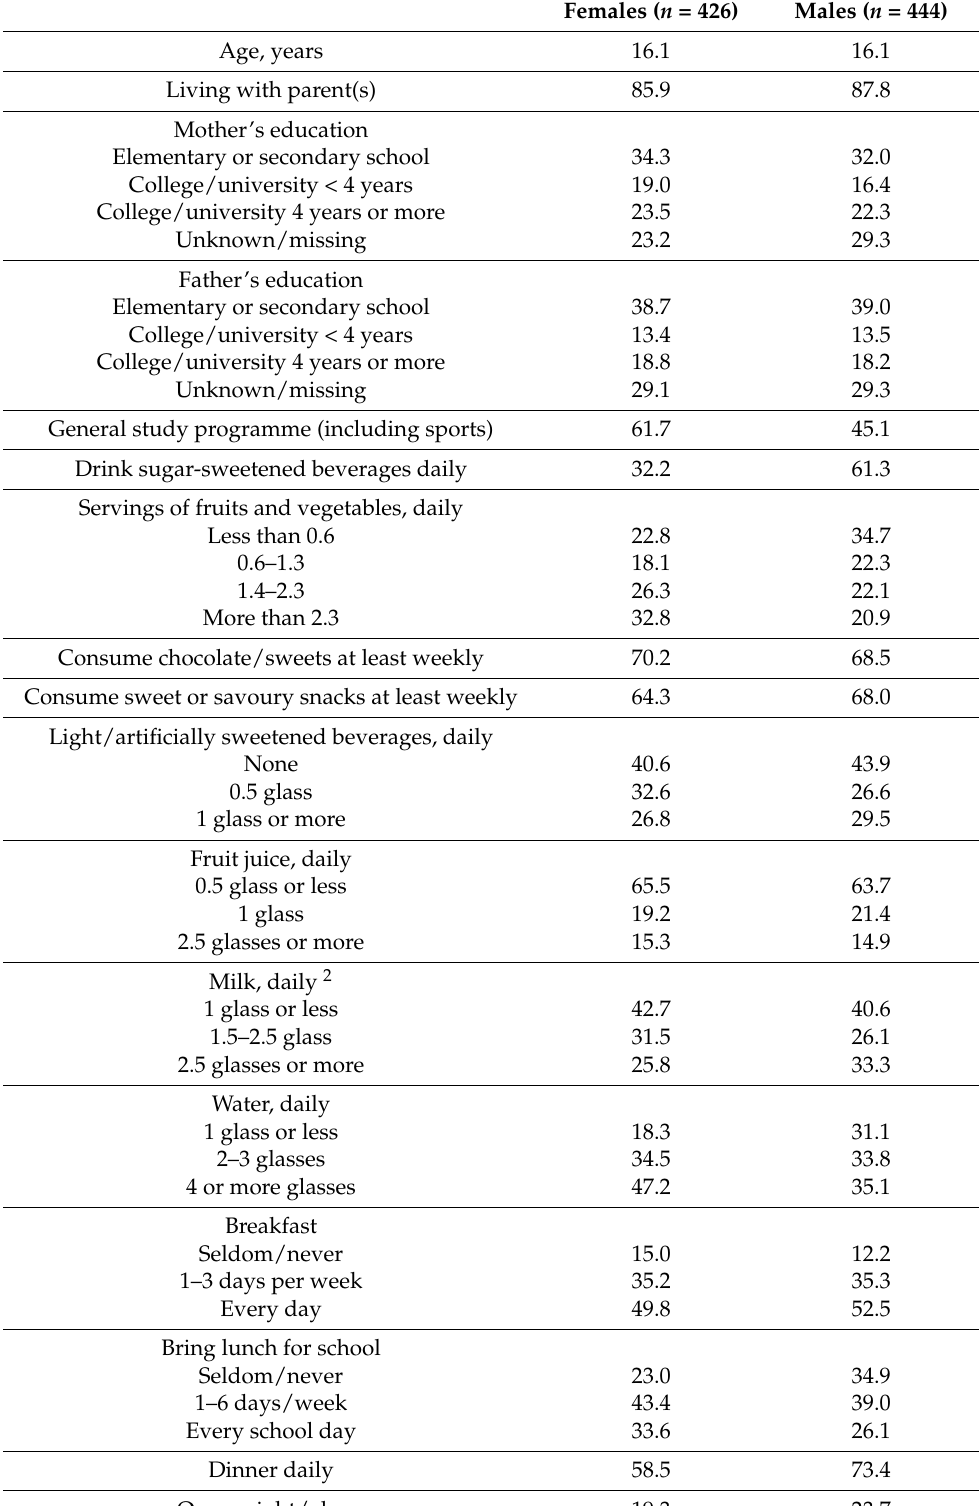
Table 1. Characteristics 1 of the participants in the Tromsø study: Fit